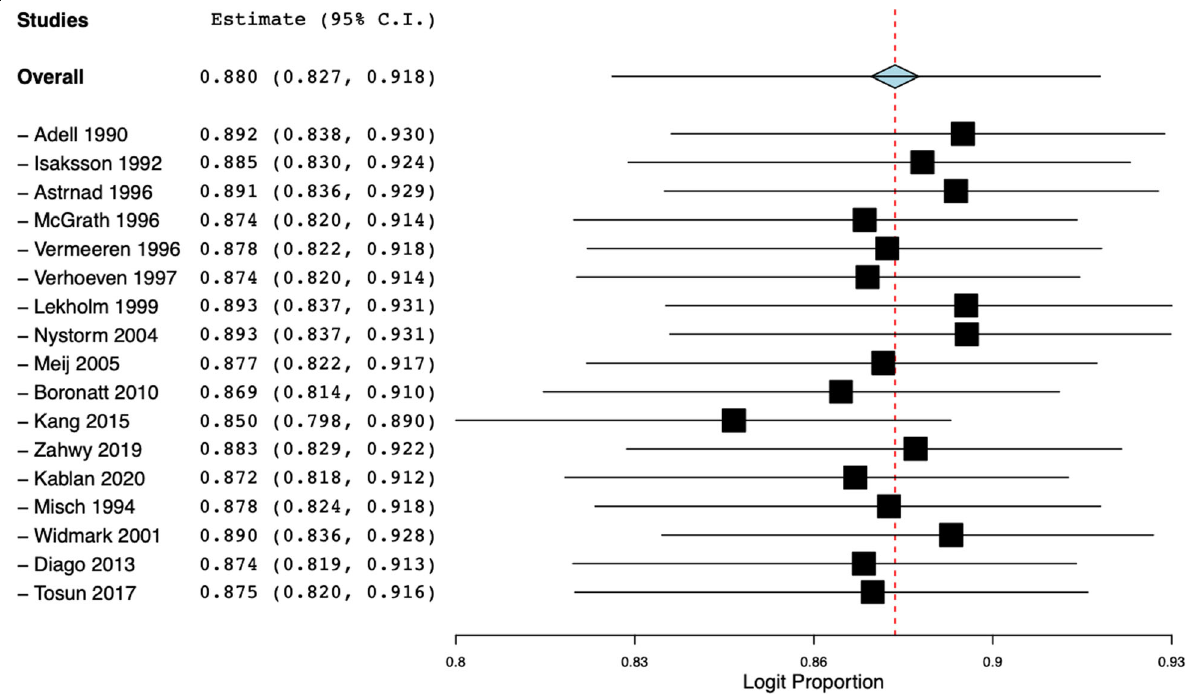
Fig. 3 Results of sensitivity analysis presenting pooled implant survival after sequential exclusion of one study at a